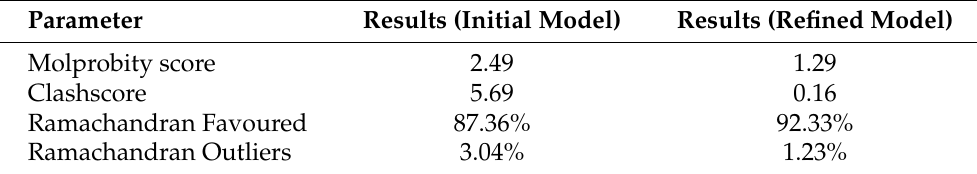
Table 1. Homology model stereochemistry validation with Molprobity